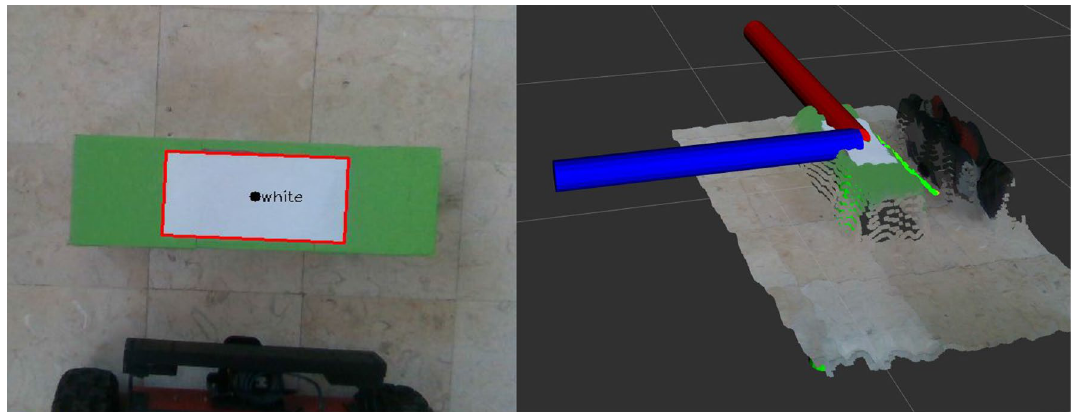
face. Right: The center pose with axis aligned to the brick is com- puted and communicated to the manipulator planner